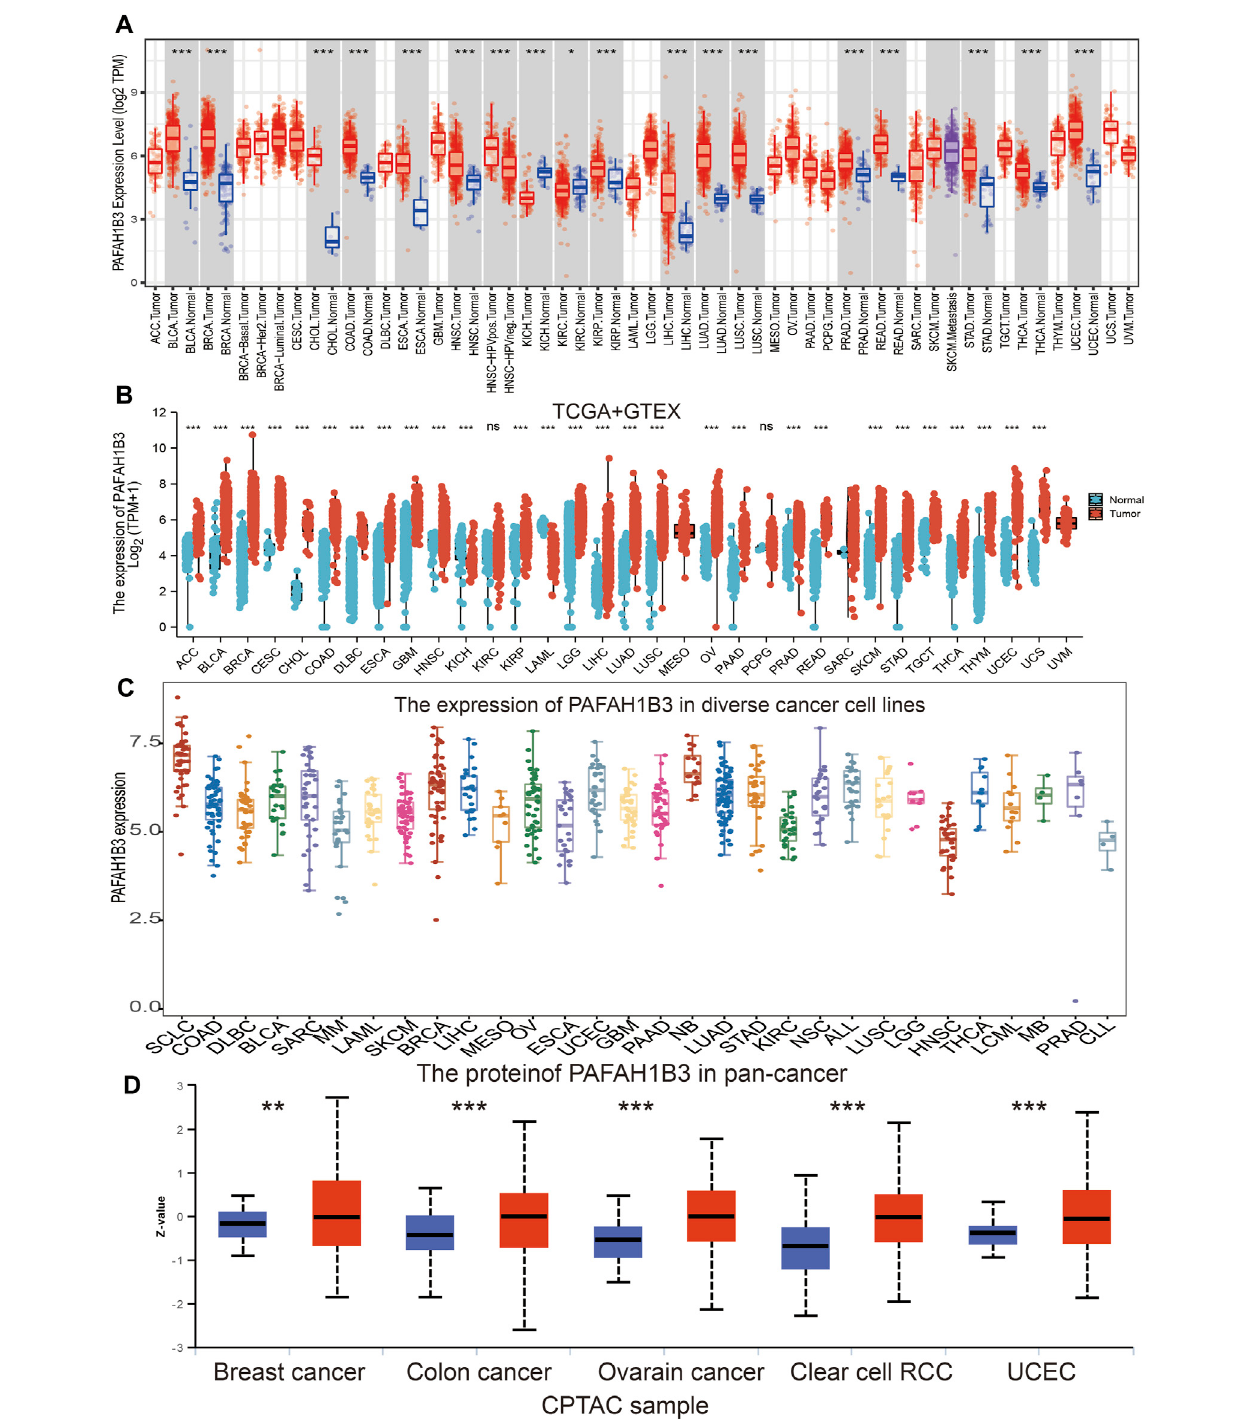
FIGURE 1 | Expression analysis for PAFAH1B3 in human cancers. (A) The expression of PAFAH1B3 in pan-cancer analysis by TIMER database. (B) The expression of PAFAH1B3 in pan-cancer analysis by TCGA/GTEx database. (C) The expression of PAFAH1B3 in diverse cancer cells lines examine by the CCLE database. (D) The protein expression of PAFAH1B3 in various cancers analysis by Ualcan database.